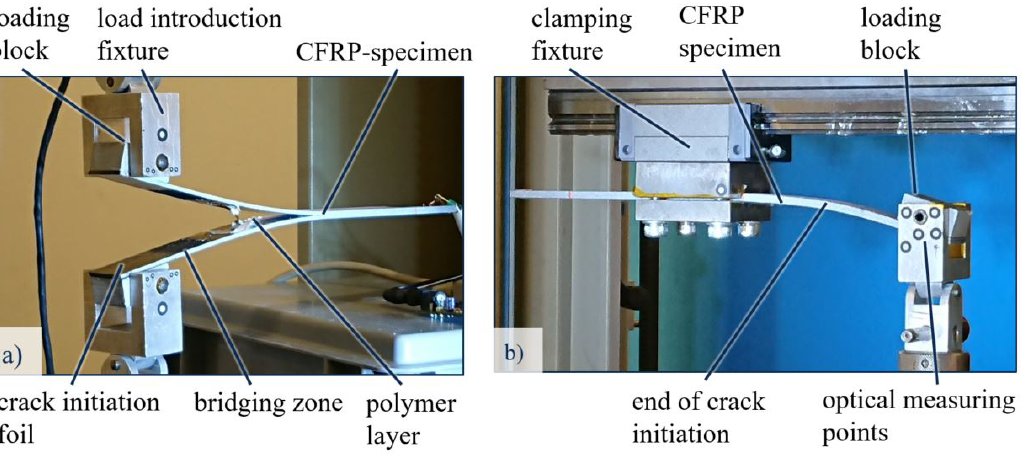
Figure 3. Experimental setup for ( a ) Mode I DCB and ( b ) Mode II ELS